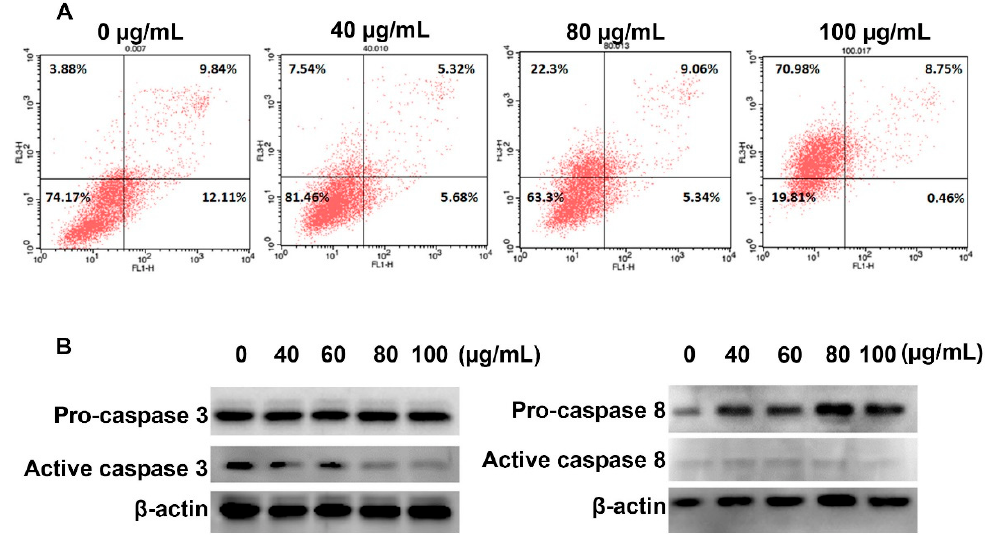
Figure 6. Effect of YLE on ( A ) the cell death mechanism and ( B ) the expression levels of proteins in HepG2 cells. The figure shows one of three independent experiments.